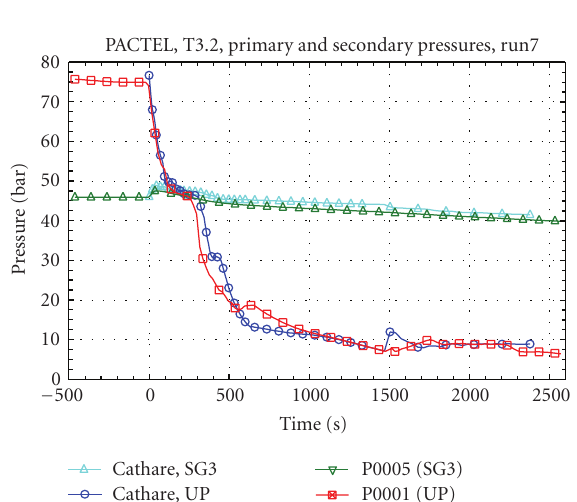
Figure 10: Upper plenum temperatures.